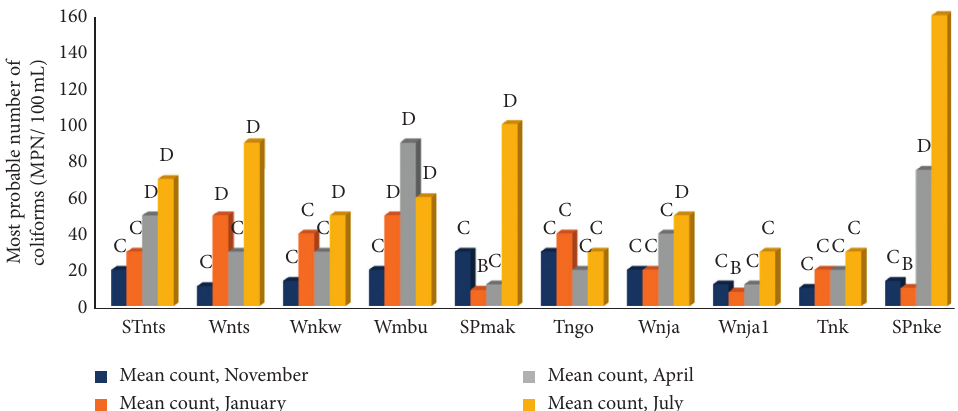
Figure 2: Most probable number of coliforms in 100mL of water between November 2017 and July 2018. A � excellent; B � acceptable, low risk; C � unacceptable, high risk; D � grossly